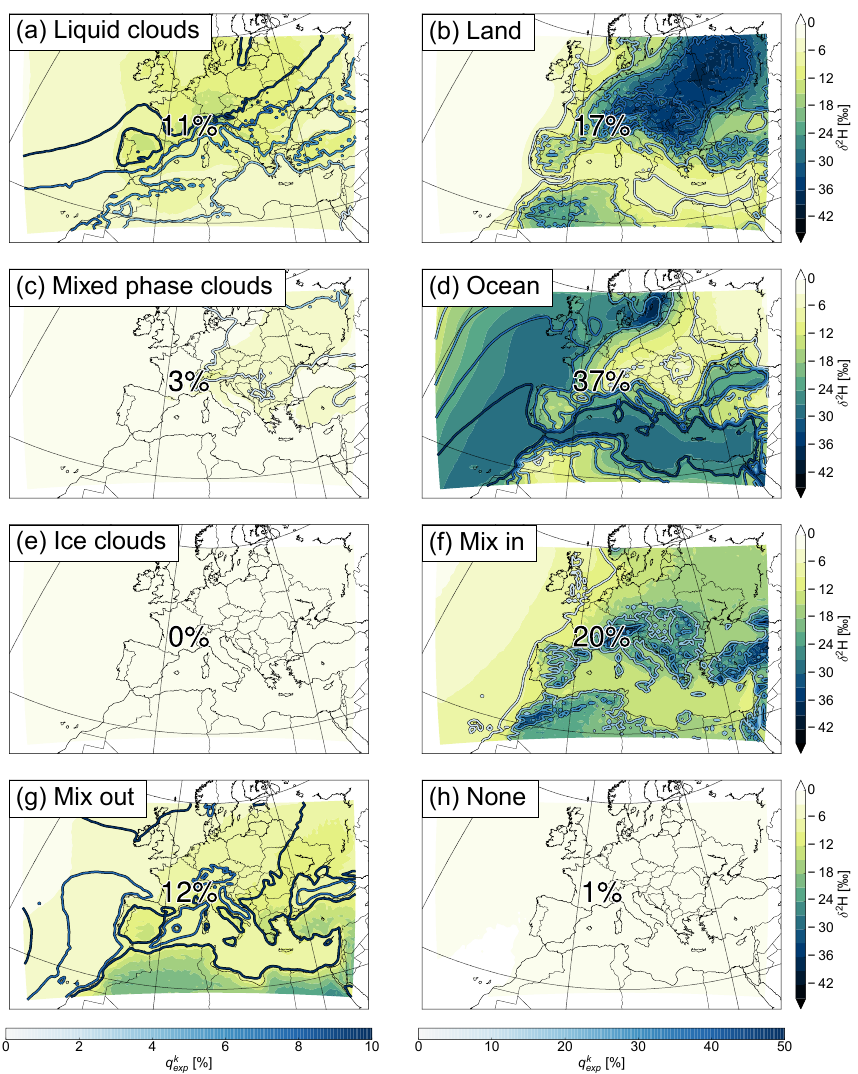
Figure 8. Contributions of the processes to (cid:49)δ 2 H in Fig. 7e. The numbers show the mean contribution of each process and the contours show q k exp (see Eqs. 10 and 11) in %. Note the different colour scales for q k exp between the left- and right-hand sides.